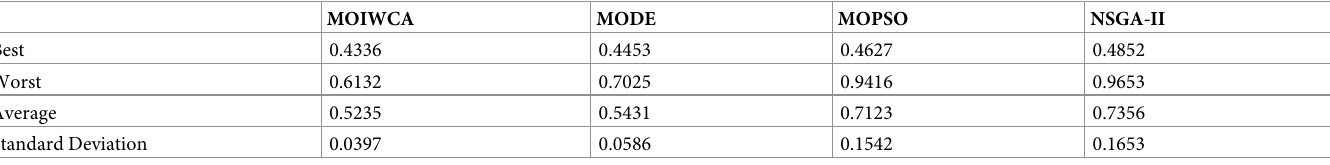
Table 6. Comparison of Spacing metric for different